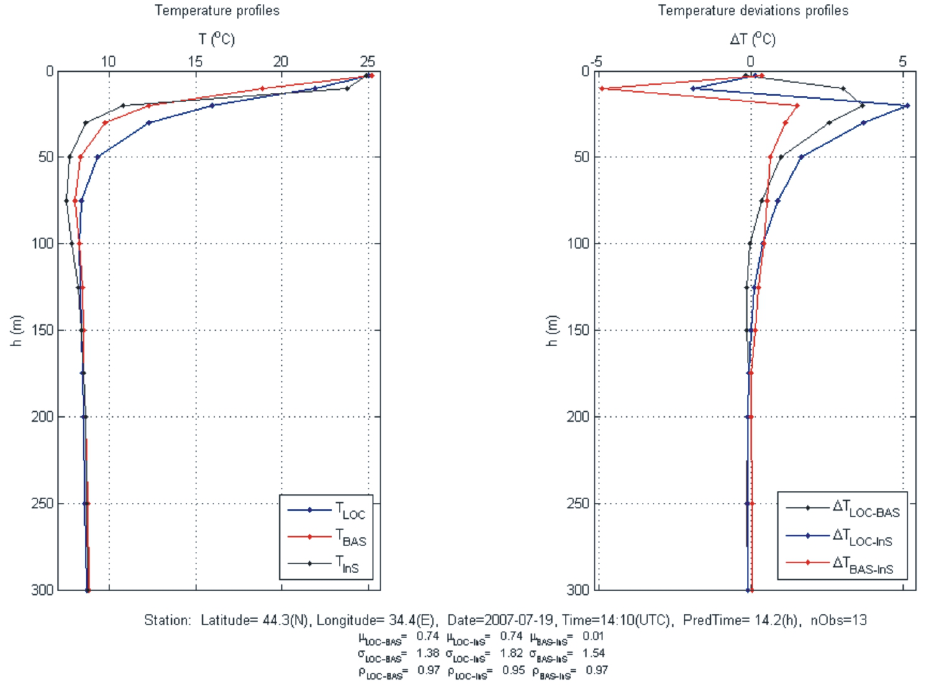
Fig. 11. The same as in Fig. 9, but for the station on the north-western